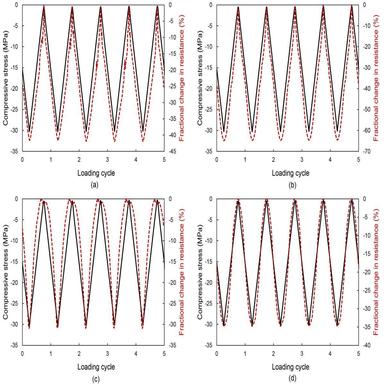
Piezoresistive sensing performances of samples with TWCNT content of (a) 0.1, (b) 0.2, (c) 0.3, and (d) 0.5% under cyclic loadings.